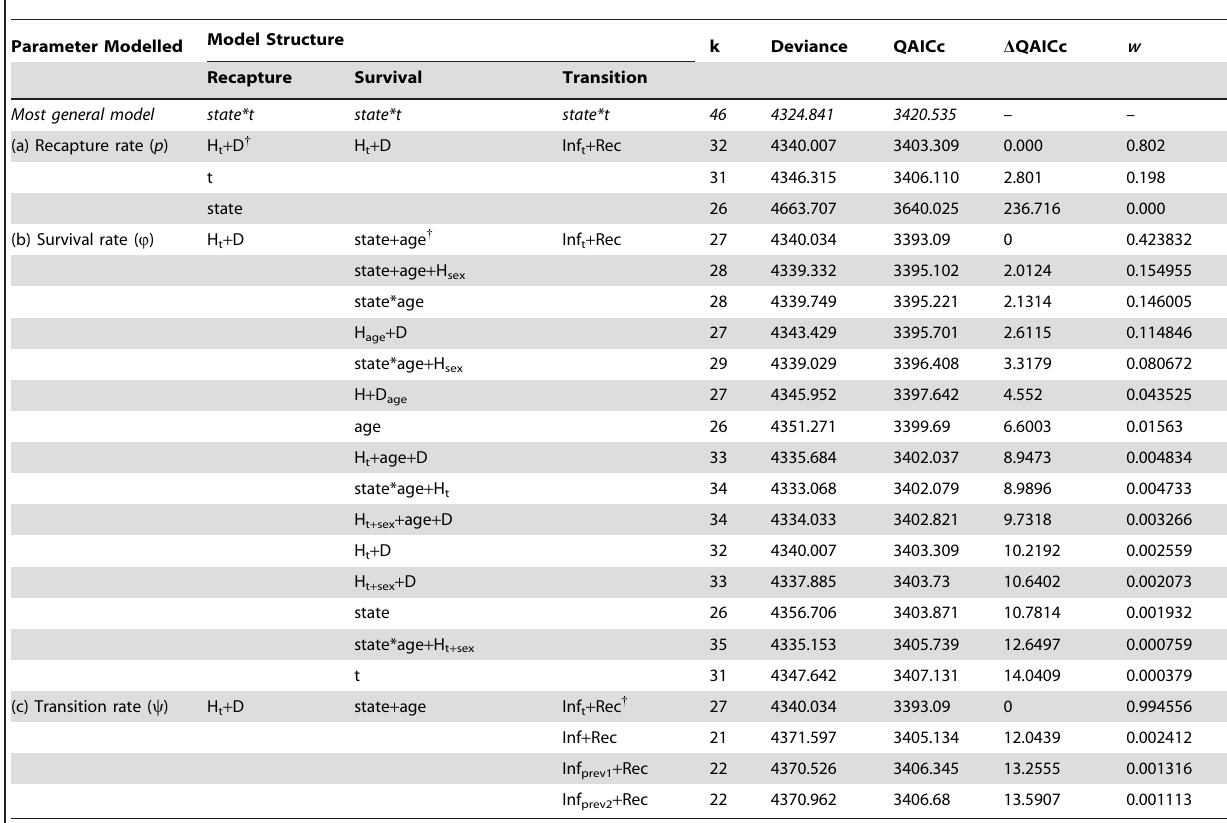
Table 3. The impact of Paridae pox on monthly recapture, survival and transitions rates of great tits.